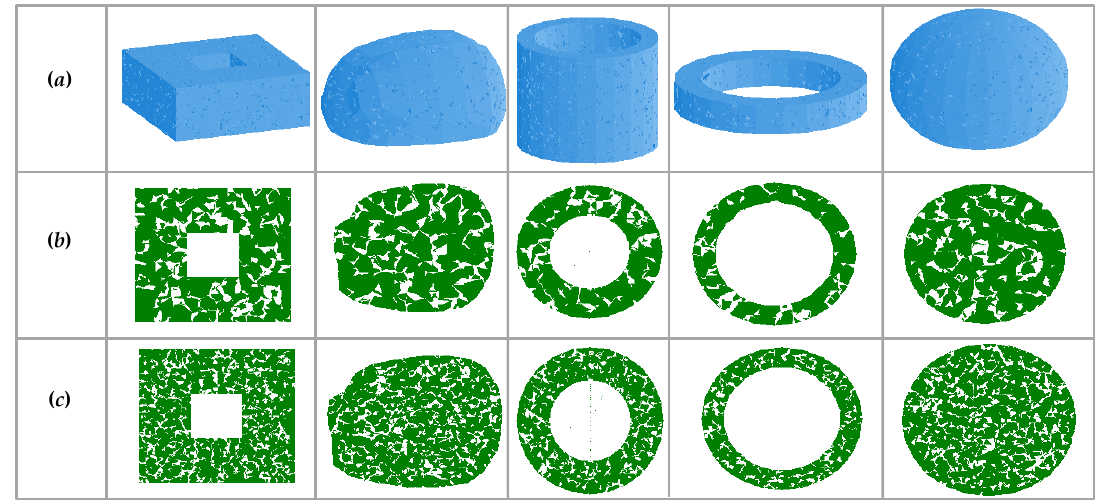
Figure 3. Point cloud-based porous structuring: ( a ) porous structures having different boundaries; ( b ) cross-sections of the respective porous structures; ( c ) cross-sections when the density of points increased by eight times. Reprinted with permission from ref. [62].Copyright 2021 ELSEVIER LICENSE.